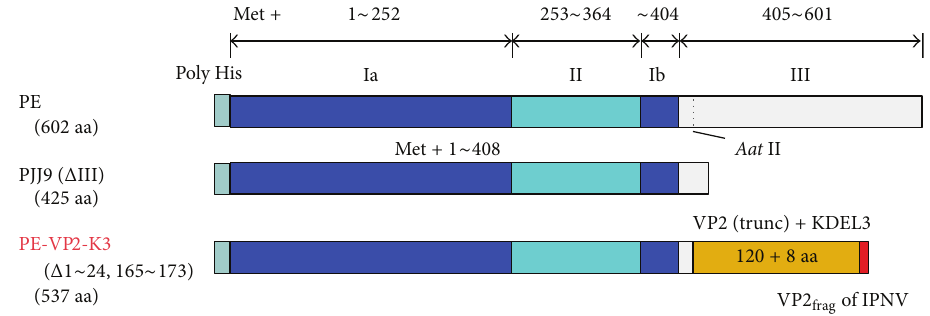
Figure 2: The fusion of the VP2- of IPNV to the Pseudomonas aeruginosa exotoxin A (PE). PE shows a 602 aa exotoxin for Pseudomonas aeruginosa made of three domains. Domain Ia (blue) located on 1–252 aa followed by domain II (green) on the location 253–364 aa, domain Ib (blue) located on 365–404 aa, and finally domain III on the extreme end located on 405–601 aa. PJJ9 ( Δ III) is a 425 aa long intermediate phase in which the toxic moiety of domain III has been cleaved. PE-VP2-KE is the final construct in which the toxic moiety of domain III has been replaced with the truncated VP2 (yellow) immunogenic protein of infectious pancreatic necrosis virus (IPNV). Note that the VP2 is attached to the KDEL3 signaling peptide